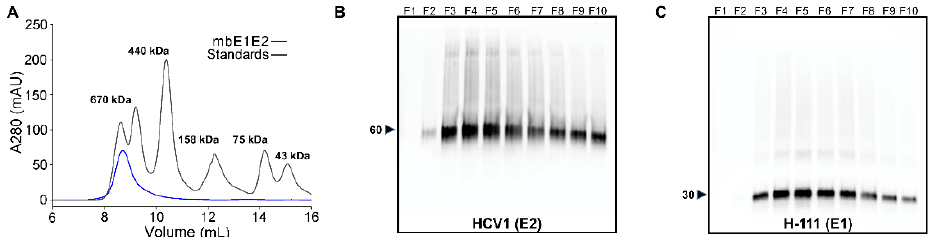
Figure 5. Analysis of purified recombinant mbE1E2. ( A ) SEC profile of mbE1E2 purified from Expi293 cell extracts ( B ) Reducing anti-E2 Western blot analysis of eluted fractions. ( C ) Reducing anti-E1 Western blot analysis of eluted fractions. Molecular weights, in kDa, of the Western blot markers closest to observed bands are indicated on the left panels of ( B ) and ( C ). Reproduced in modified form with permission from [22].